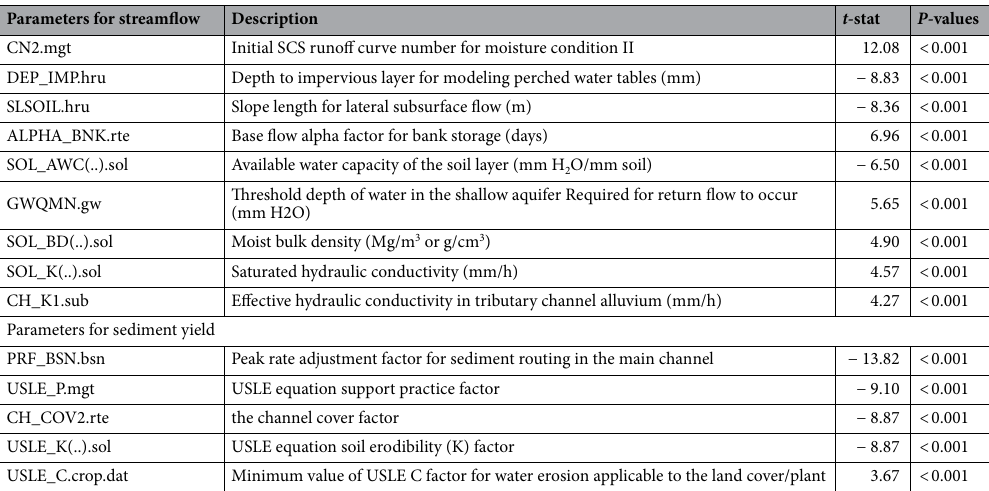
Table 2. Summary of the most sensitive parameters influencing the streamflow and sediment yield in the Anzali wetland watershed .